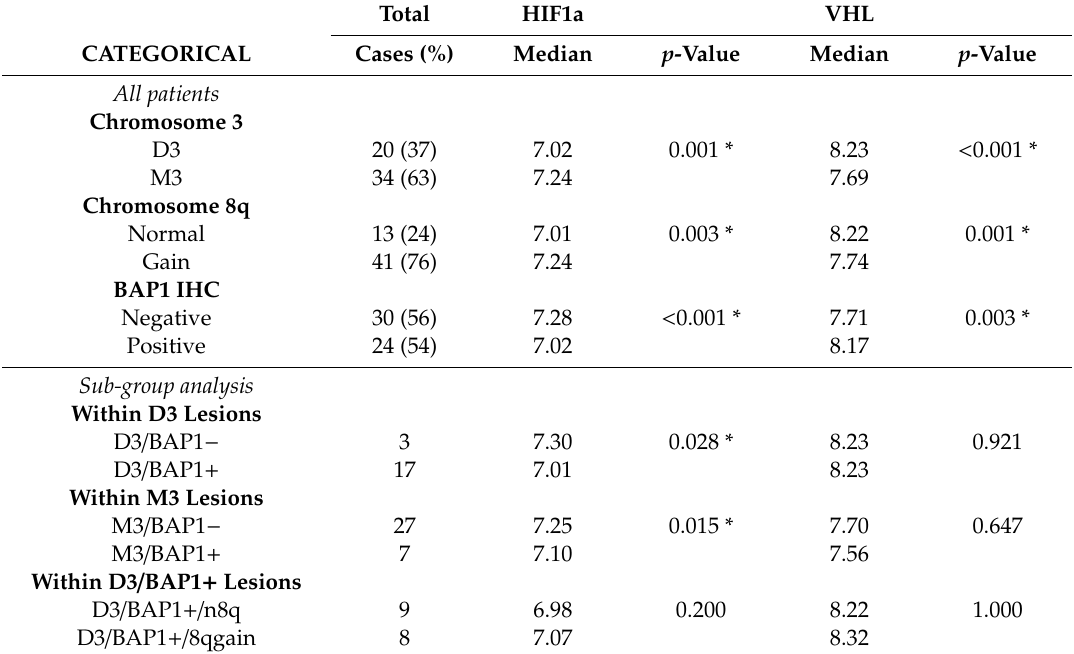
Table 3. Analysis of hypoxia-inducible factor 1-alpha (HIF1a) and von Hippel–Lindau (VHL) mRNA expression in relation to chromosome status and BAP1 (based on the n = 54 lesions with data on HIF1a / VHL and chromosome status from the Leiden data). Total HIF1a